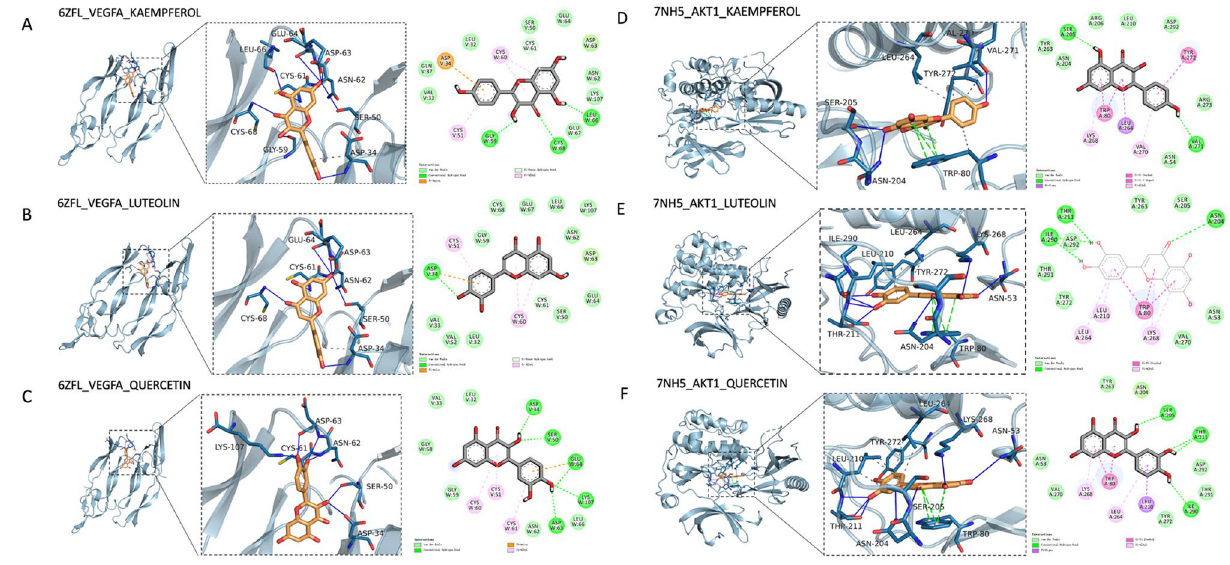
Figure 4. The compounds dock with VEGFA and AKT1. Molecular docking diagrams of VEGFA with kaempferol ( A ), luteolin ( B ), and quercetin ( C ). Molecular docking diagrams of AKT1 with kaempferol ( D ), luteolin ( E ), and quercetin ( F